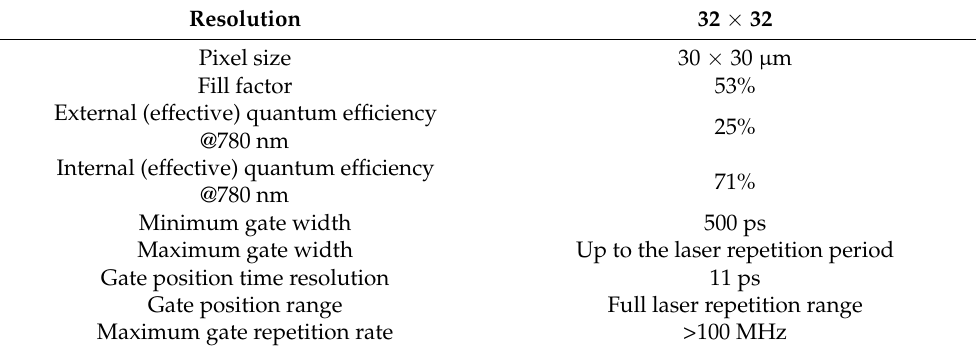
Table 2. Proof-of-concept CAPS camera characteristics.